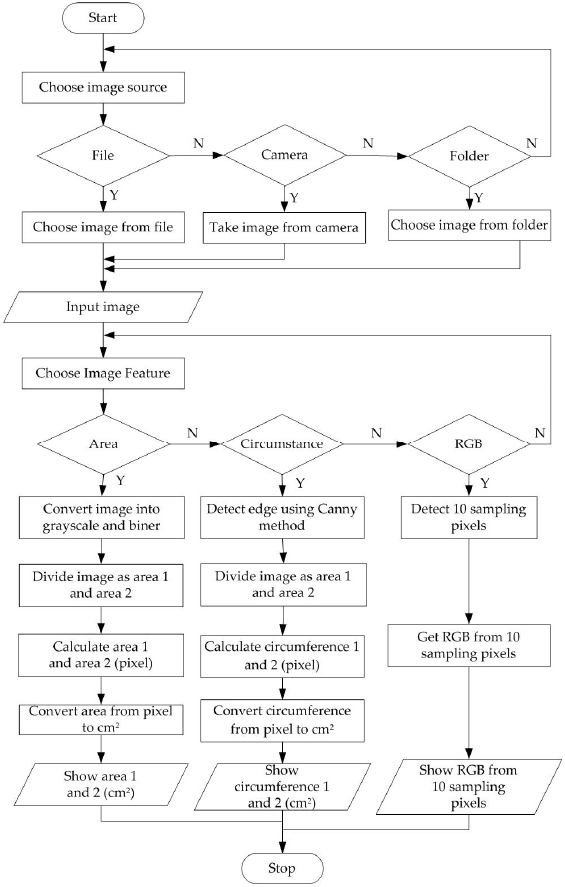
Figure 4. Process of feature processing.